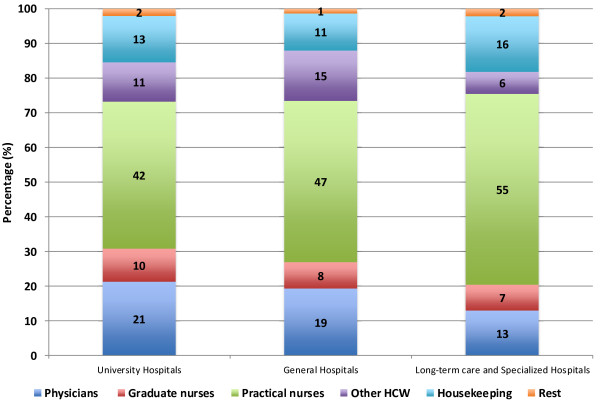
Proportions of healthcare workers included in the study, overall and stratified by type of hospital and occupation, based on data from the national surveillance program of the National Hospital Infection Control Advisory Committee, all 66 public hospitals in Croatia, 2006–2011.